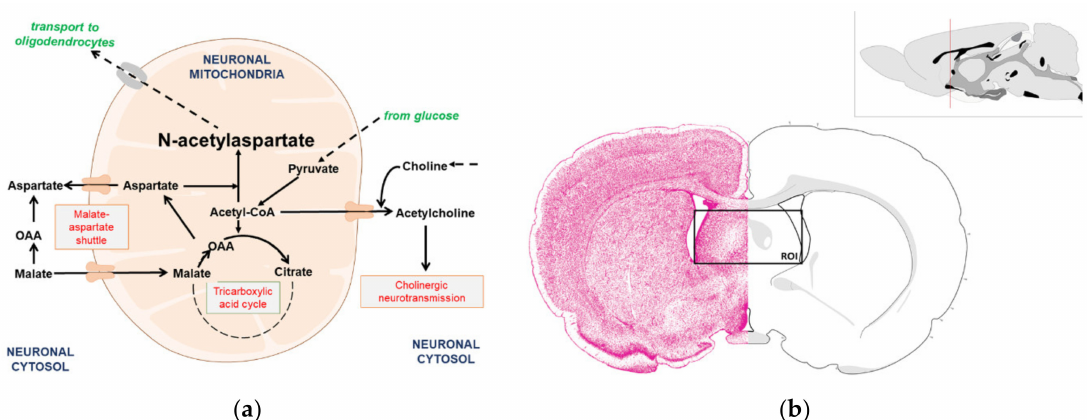
Figure 1. Graphical presentation of the background of this study: ( a ) N -acetylaspartate production involves acetyl-CoA and aspartate metabolites; ( b ) representative rat brain section showing the brain septum as a region of interest (ROI) analyzed in this study. Upper image: the cartoon of rat brain sagittal section with red bar indicates the location of the cut used to isolate brain septum tissue. Lower image: resulting cross-section of brain tissue with the brain septum exposed (marked with a